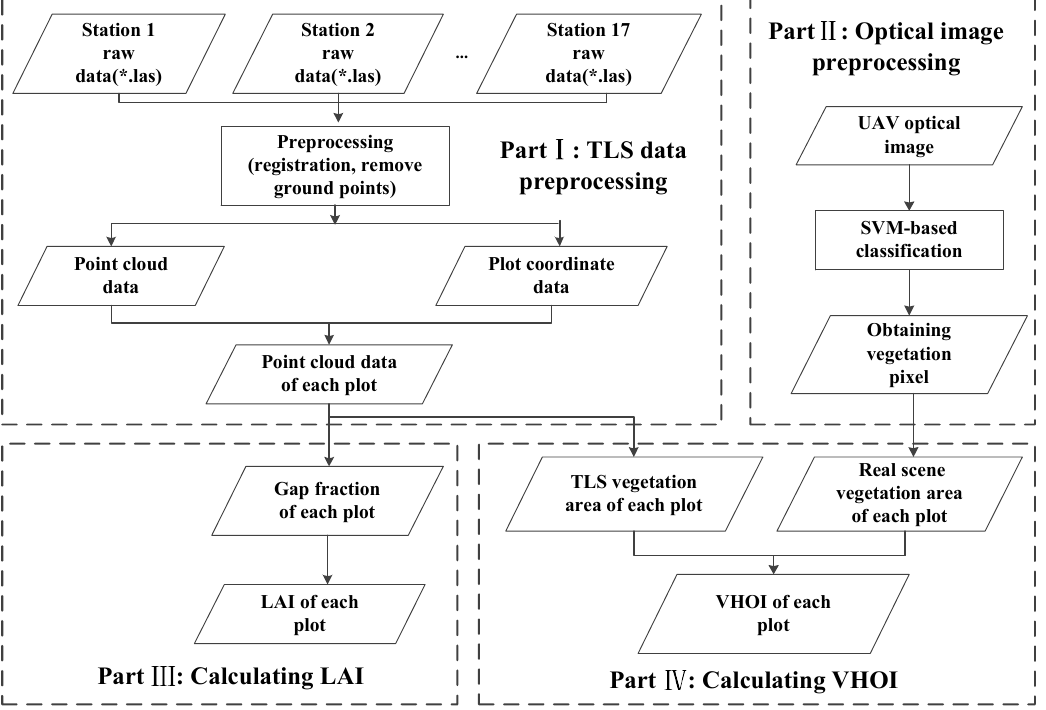
Figure 2 . Schematic representation to example the different steps for retrieving LAI and vegetation horizontal occlusion index